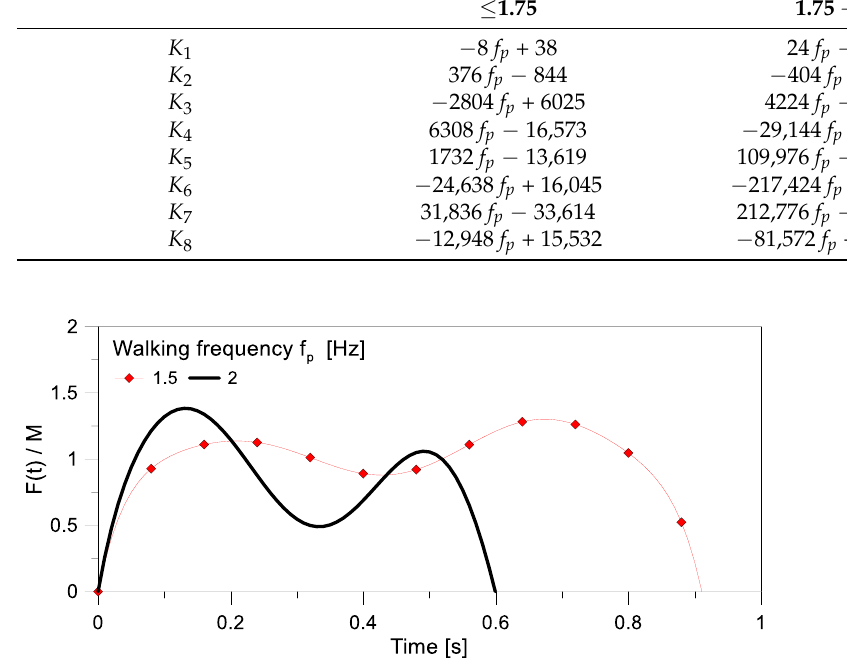
Figure 5. Example of analytical description of single footfall vertical load, based on the equivalent- force deterministic model as in Equation (14). Vertical load F (in Newton) is normalized to the mass of the pedestrian ( M = 80 kg). Table 2. Definition of input coefficients K i for Equation (14), based on walking frequency f p .